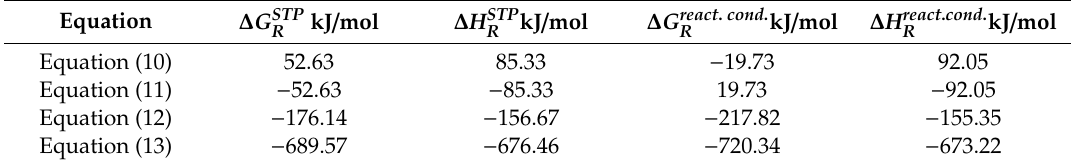
Table 9. Gibbs free energy ( ∆ G R ) and enthalpy of reaction ( ∆ H R ) of the reaction Equations (10) to